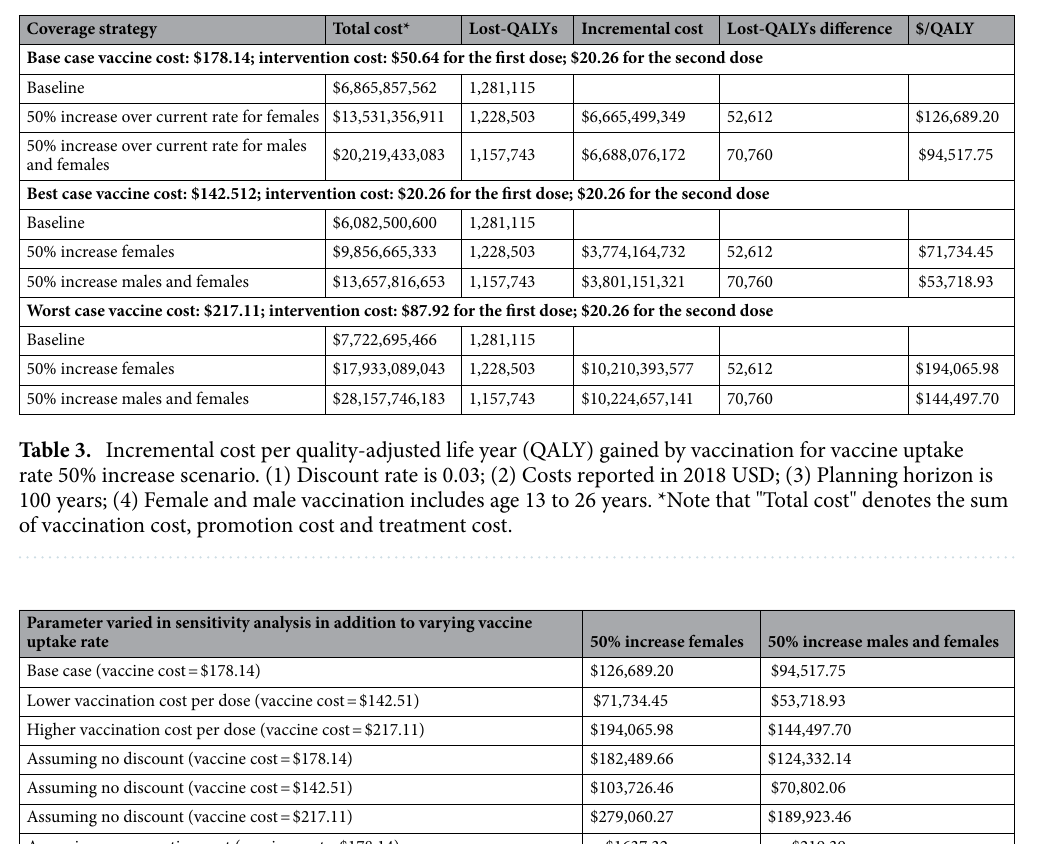
Table 4. Sensitivity analysis: estimated cost per quality-adjusted life years ($ per QALY) gained when other model parameters are varied. (1) Discount rate is 0.03; (2) Costs reported in 2018 USD; (3) Planning horizon is 100 years; (4) Female and male vaccination includes age 13 to 26 years.